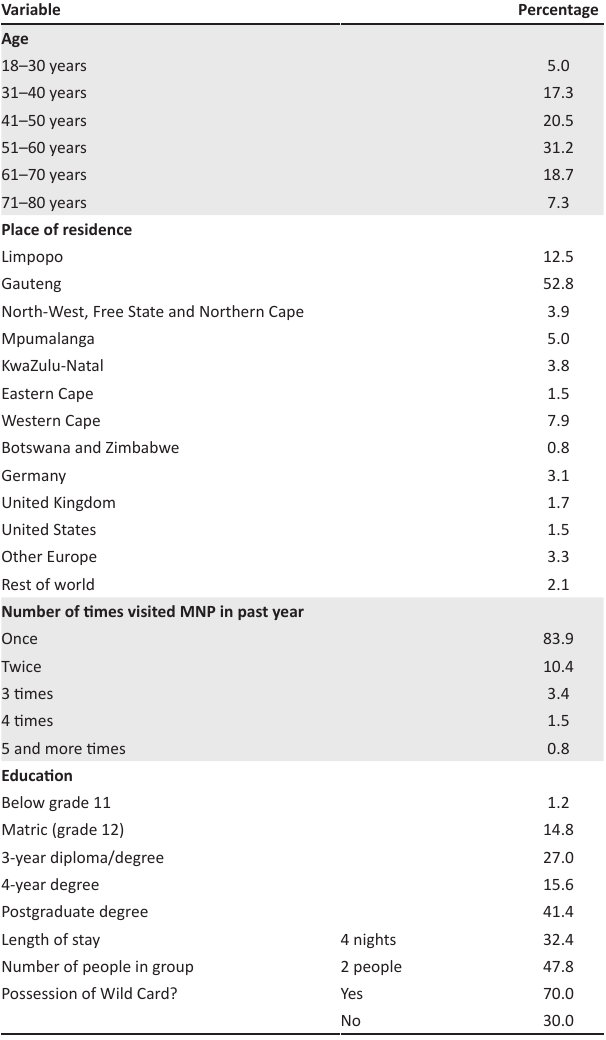
TABLE 2: Demographic profile of